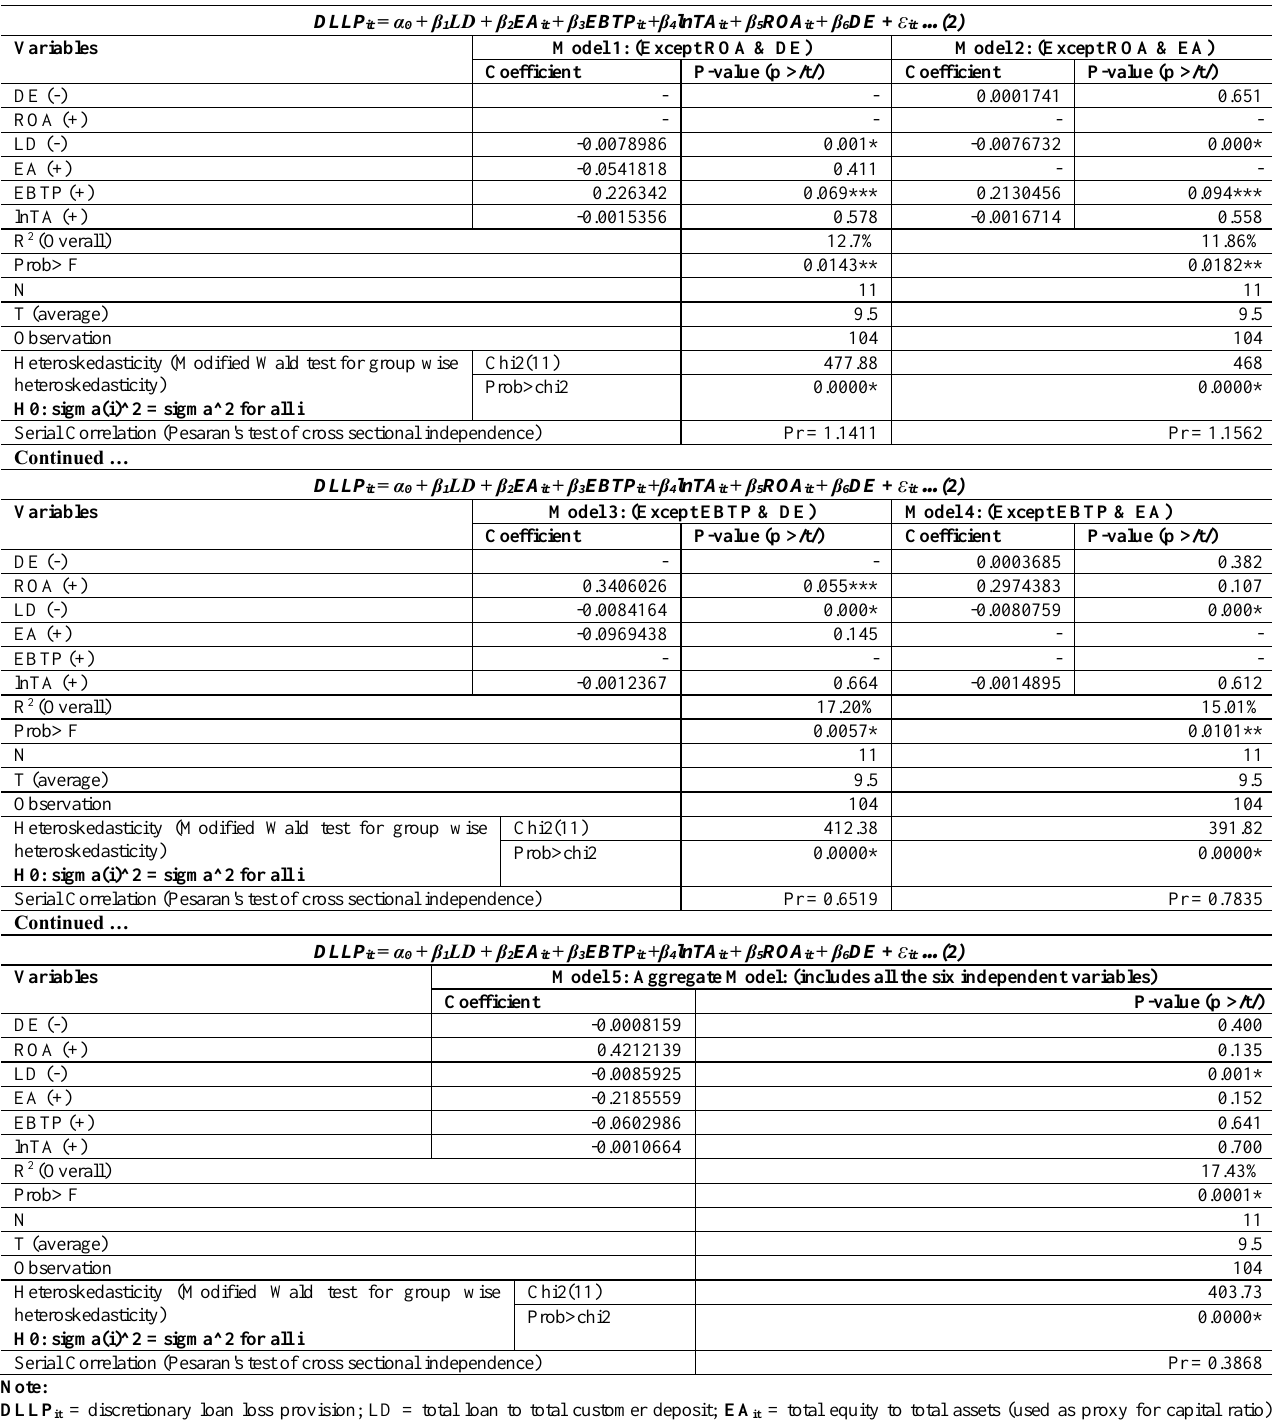
Table 6: Fixed effect regression